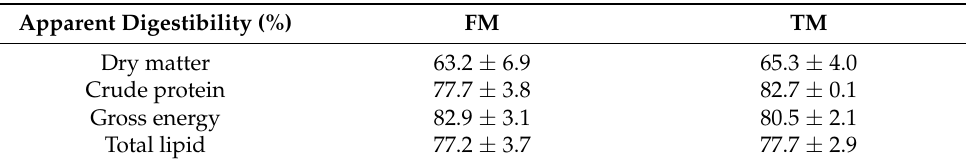
Table 2. Apparent digestibility of dry matter, crude protein, gross energy and total lipid for the two diets of this study. Results are mean ± S.E. ( n = 3). No statistical difference was found. Apparent Digestibility